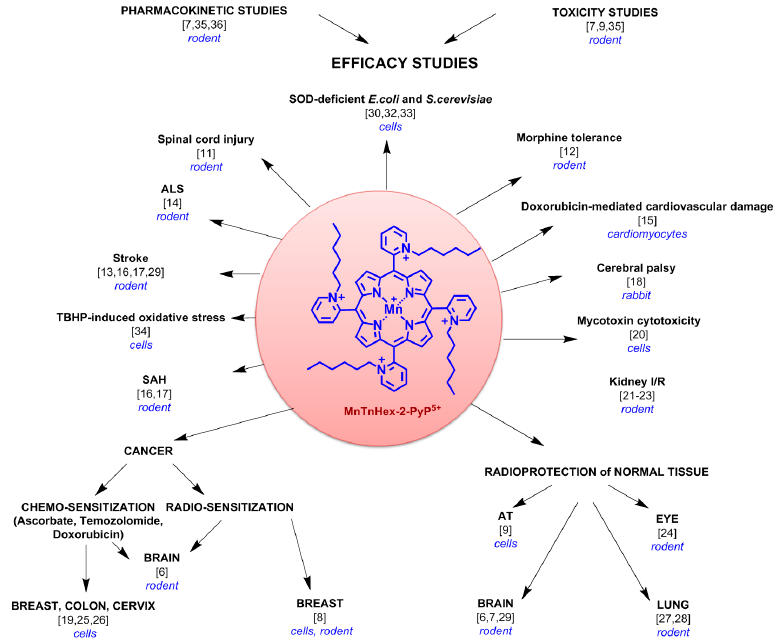
Figure 1. Structure and therapeutic effects of manganese (III) meso -tetrakis ( N -hexylpyridinium-2-yl) porphyrin, MnTnHex-2-PyP 5+ (hexyl). The therapeutic efficacy of hexyl was observed at the level of normal tissue injury and cancer. Hexyl protected normal tissue from oxidative stress injury, including radiation, at extremely low levels of 0.05 mg/kg. Yet, it did not protect